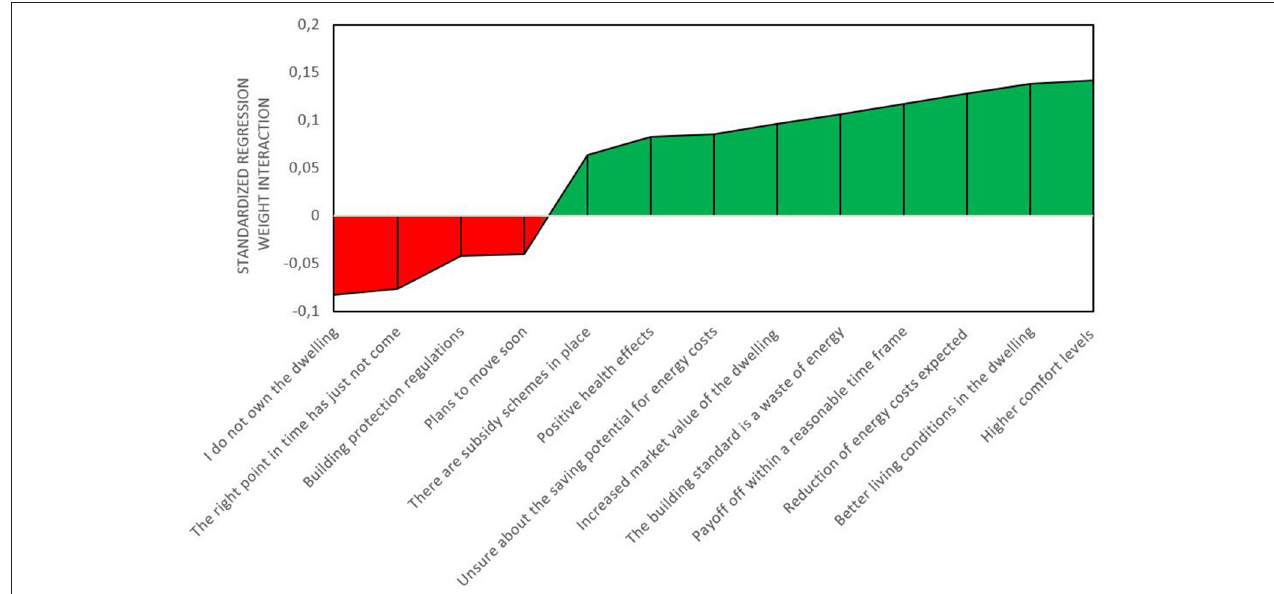
FIGURE 2 | Significant barriers and drivers for the transition from not being in a decision mode (reverse coded) to deciding what to do